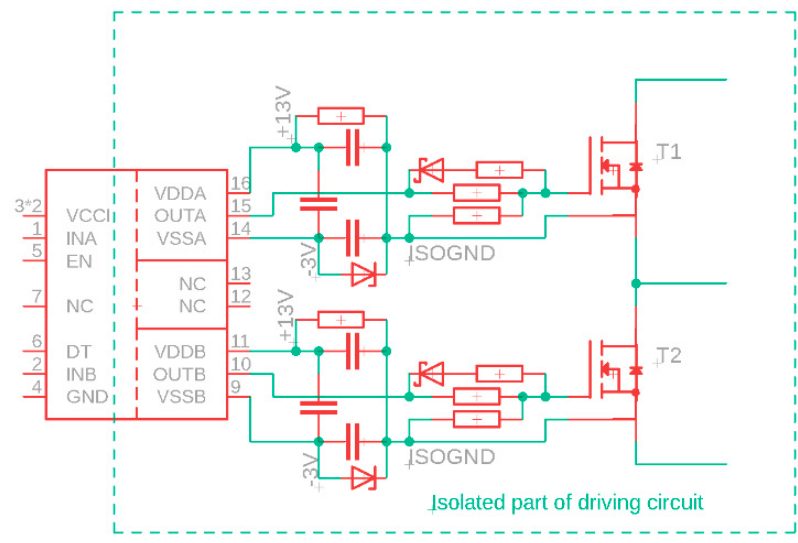
Figure 5. Driver’s output stage configuration of driver connected to power stage.